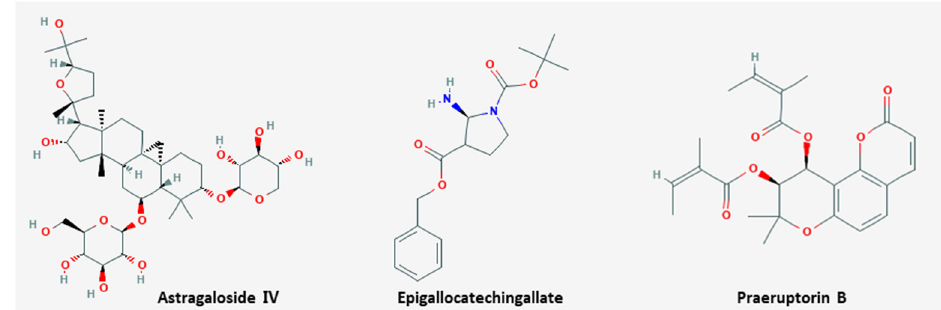
Figure 2. Chemical structures of compounds derived from natural products inhibiting metastasis. Table 4. Metastasis inhibiting natural products.